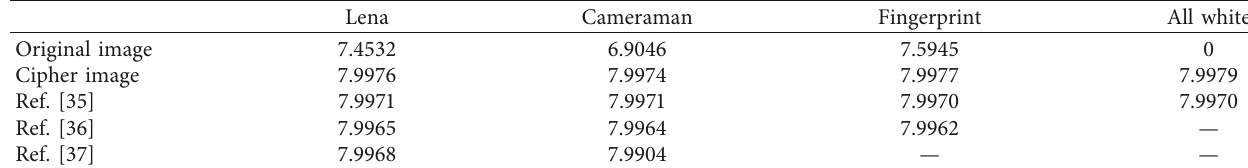
Table 4: Entropy of images.